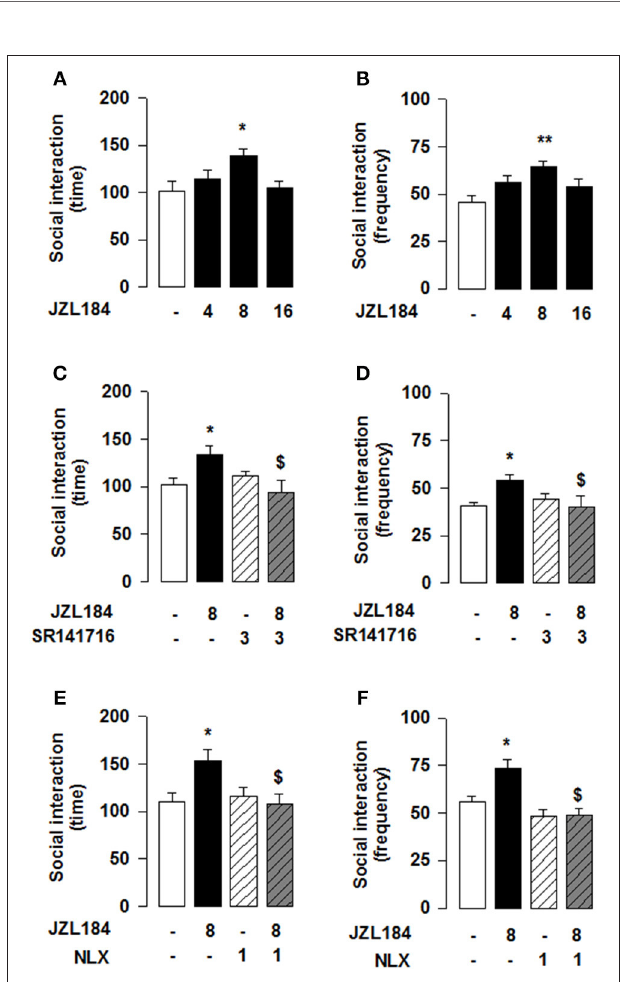
FIGURE 4 | 2-AG elevation in adolescent mice stimulates social behavior through CB1R and OR. JZL184 (8 mg/kg, i.p.) increased the total time (A) and frequency (B) of social interaction. Pre-treatment with the CB1R antagonist SR141716 (3 mg/kg, i.p.) antagonized these effects (C,D) . In addition, pre-treatment with the OR antagonist naloxone (1 mg/kg, s.c.) prevented the effects of systemic JZL184 on social behavior (8 mg/kg, i.p.) (E,F) . Data represent mean ± S.E.M. time (A,C,E) and frequency (B,D,F) of social interaction. * p < 0.05, ** p < 0.01 vs. vehicle; $ p < 0.05